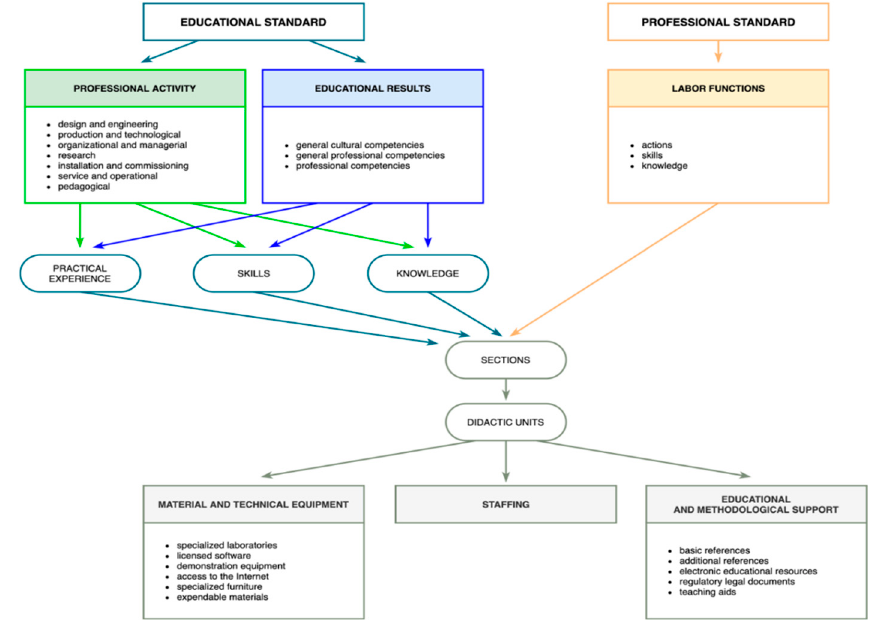
Figure 2. Structural elements of an educational program.